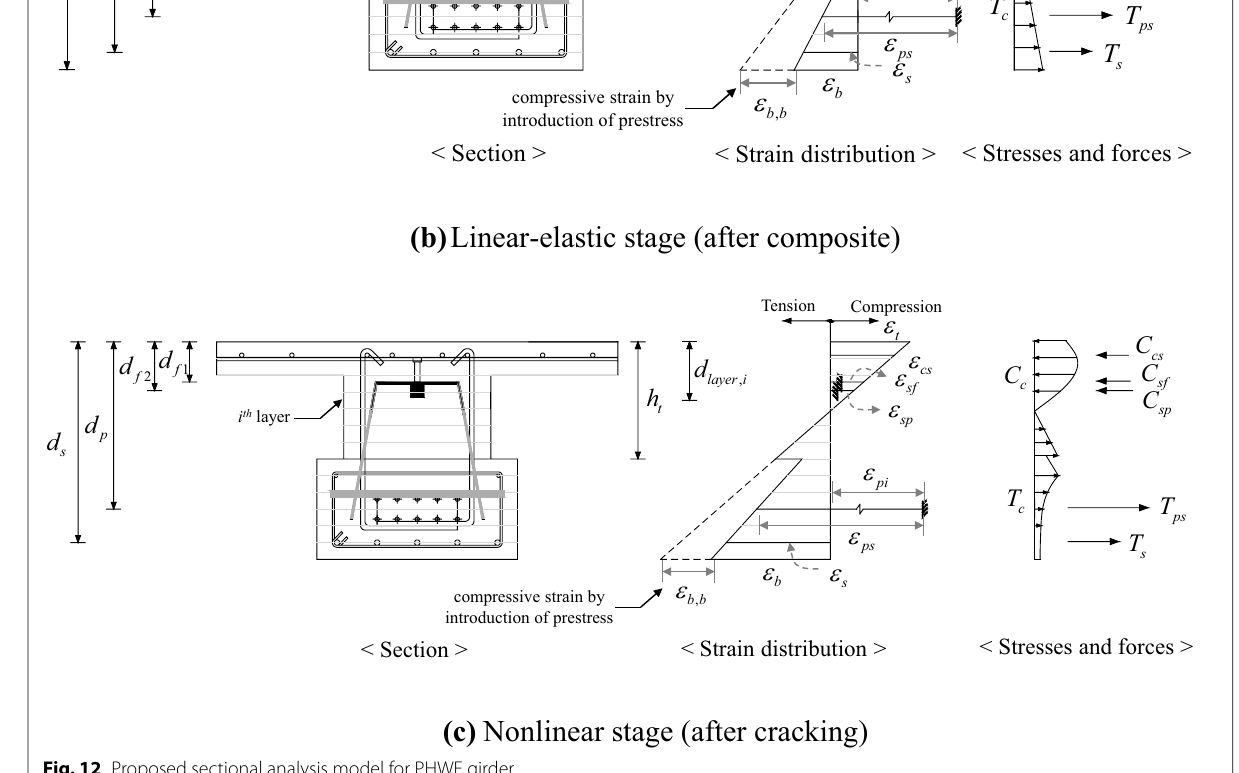
Fig. 12 Proposed sectional analysis model for PHWF